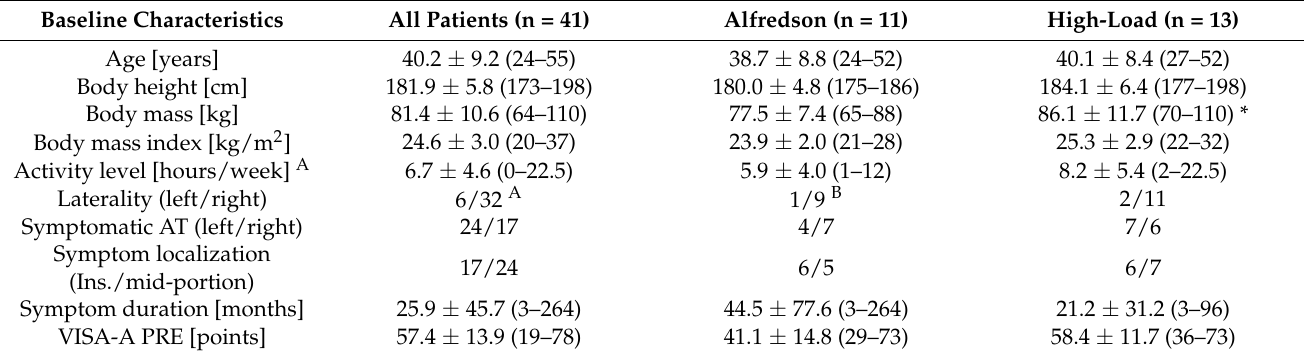
Table 1. Baseline characteristics of overall patient group (n = 41) and of intervention groups: Alfredson group (n = 11) and high-load group (n = 13). Values of baseline characteristics are presented as mean ± SD (standard deviation) and range in